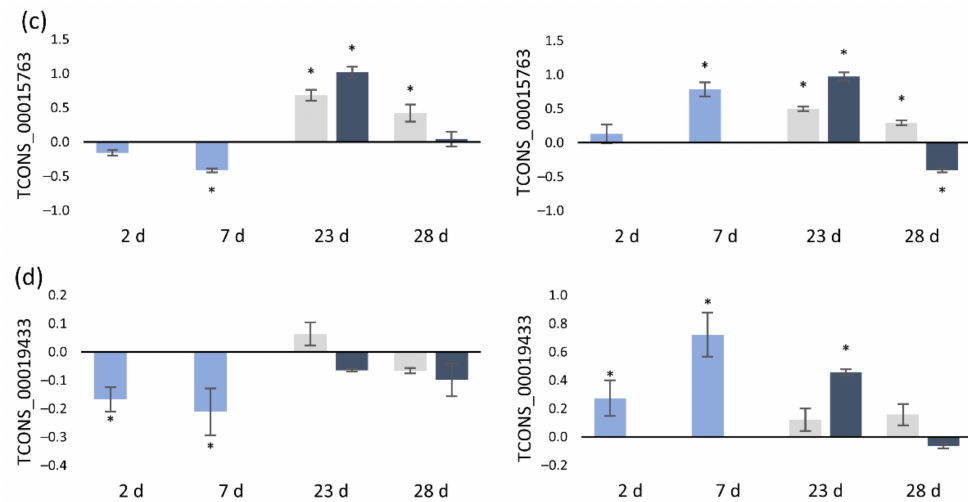
Figure 6. Expression profiles of four lncRNAs, i.e., TCONS_00003968 ( a ), TCONS_00008071 ( b ), TCONS_00015763 ( c ), and TCONS_00019433 ( d ), depicting differences in the expression levels in non-primed plants in WL-T and WL-S cucumber accessions under waterlogging stress. 1xH—non-primed plants, Rec—non-primed plants after 14-day recovery period, 2xH—primed plants. Data are expressed as the mean ± SD (standard deviation) of three independent biological replicates and three technical replications. Asterisks indicate a significant difference vs. control